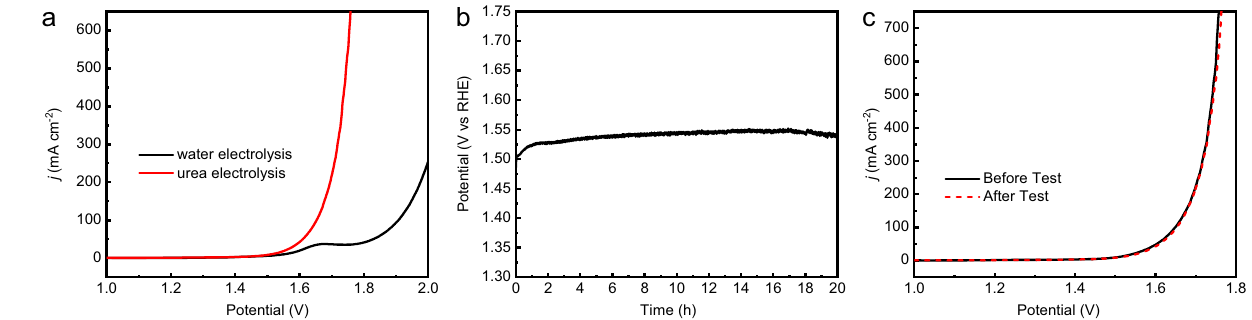
Figure 8. ( a ) LSV polarization curve of urea electrolyzed by Ni 2 P@Ni-MOF/NF electrode in 1 M NaOH with or without 0.33 M urea. ( b ) Chronopotentiometric (V-t) curve of Ni 2 P@Ni-MOF/NF // Ni 2 P@Ni-MOF/NF for urea comprehensive electrolysis at current density of 10 mA cm -2 . ( c ) LSV curve of Ni 2 P@Ni-MOF/NF before and after 20 h UOR